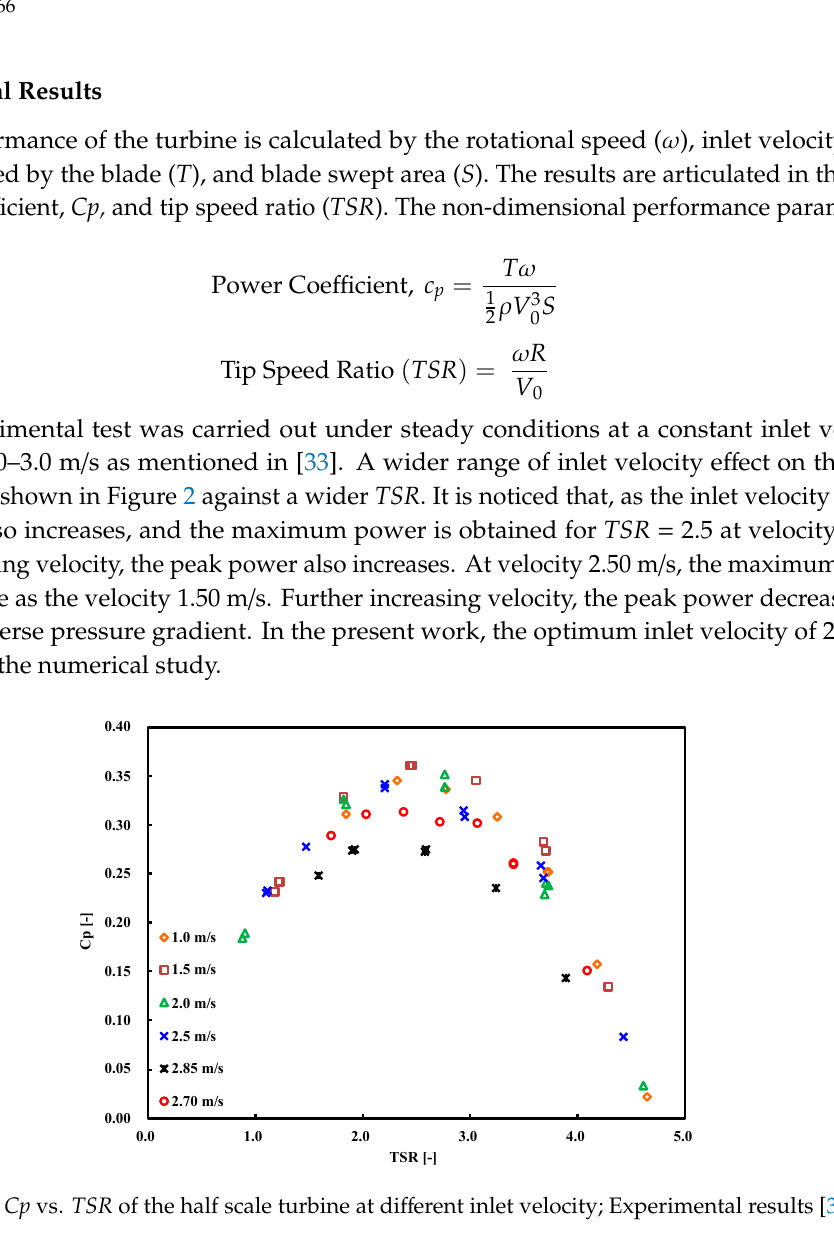
Figure 2. Cp vs. TSR of the half scale turbine at di ff erent inlet velocity; Experimental results Figure 2. Cp vs TSR of the half scale turbine at different inlet velocity; Experimental results [33].